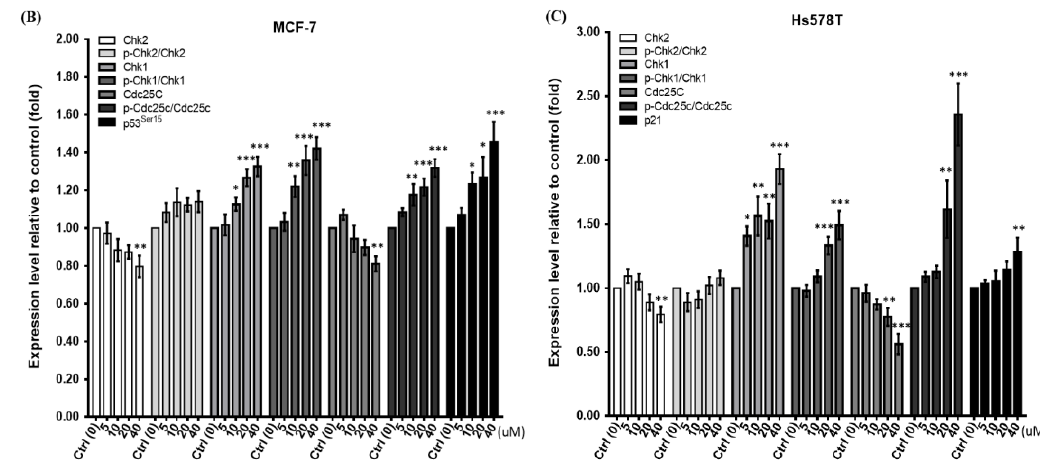
Figure 3. Diosgenin activates checkpoint proteins. ( A ) Incubation of MCF-7 (left panel) and Hs578T (right panel) cells with diosgenin increases expression of checkpoint kinase 1 (Chk1) and phosphorylated (activated) forms of Chk1 (p-Chk1 Ser345 ), p-p53 Ser15 , p21, and p-Cdc25C Ser216 . Densitometric analyses for ( B ) MCF-7 and ( C ) Hs578T cells were performed using Digital Protein DNA Imagineware. β -actin was used to normalize the amount of protein in each lane. Data are shown as means ± SD for three independent experiments. * p < 0.05, ** p < 0.01, and *** p < 0.001 vs. control (Ctrl, 0 µM) group.